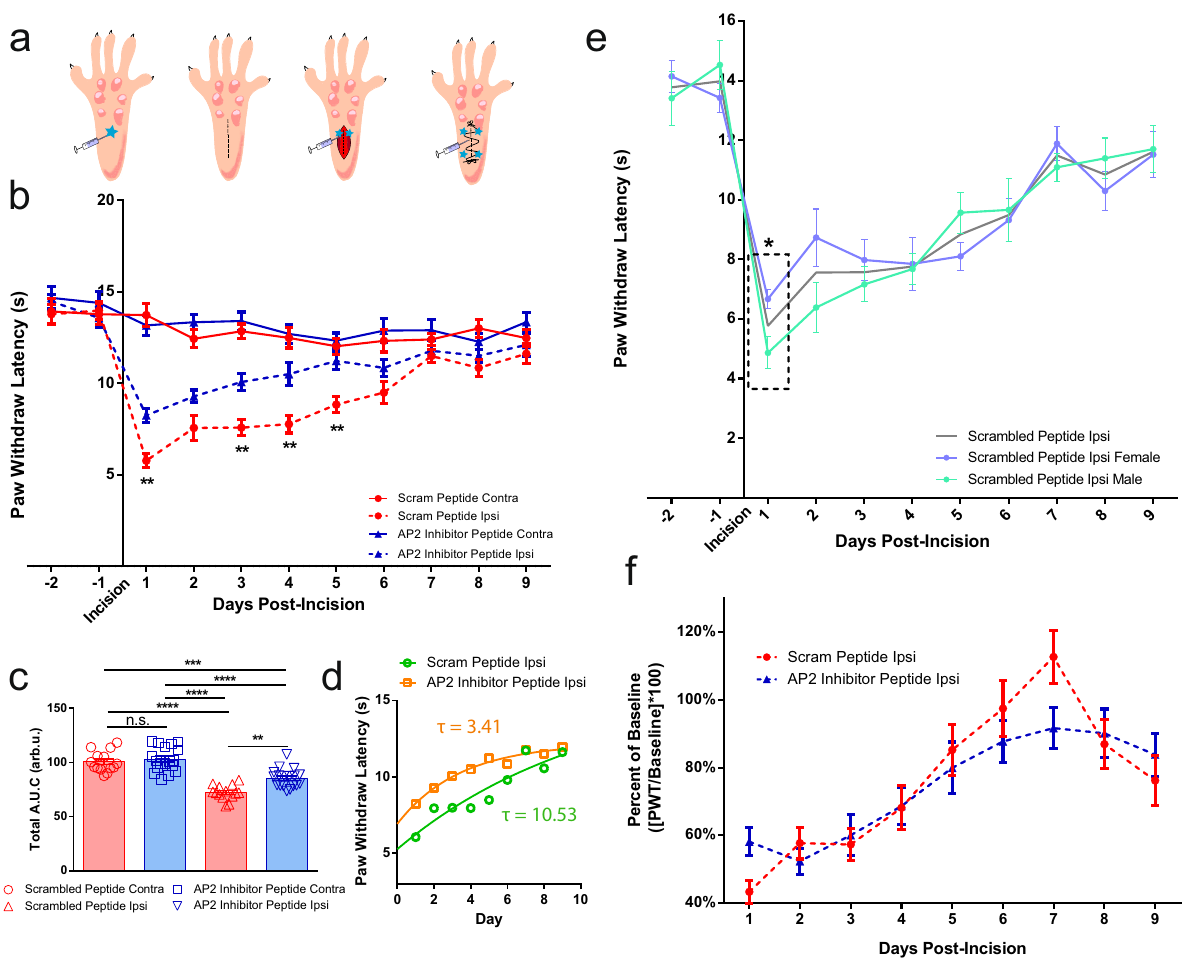
Fig. 5 Pharmacological inhibition of peripheral endocytosis by a lipidated AP2 inhibitor peptide attenuated thermal sensitivity in a post-operative pain model. a Schematic depicting injection protocol for lipidated AP2 inhibitor peptide. b Graph depicting thermal sensitivity in rats following plantar muscle incision and injection with scrambled peptide ( n = 14) or AP2 inhibitor peptide ( n = 18). Data shown is pooled males and females. Data is represented as mean PWL ± S.E.M. Signi fi cance determined using repeated measures 2-way ANOVA with Bonferroni correction p < 0.05; * p < 0.01; **. Ipsilateral scrambled peptide vs Ipsilateral AP2 peptide: Day 1 p -value = 0.0055, Day 3 p -value = 0.0048, Day 4 p -value = 0.0015, Day 5 p -value = 0.0082. c Total area under the curve (A.U.C.) quanti fi cation for all rats under experimental conditions displayed in b ; scrambled peptide ( n = 14) and AP2 inhibitor peptide ( n = 18). Pharmacological inhibition of endocytosis generated a signi fi cant increase in A.U.C. for the ipsilateral paw. Data shown is pooled males and females. Data is represented as the mean A.U.C. (in arbitrary units; Arb.u.) ± S.E.M. Statistical signi fi cance was determined using one-way ANOVA